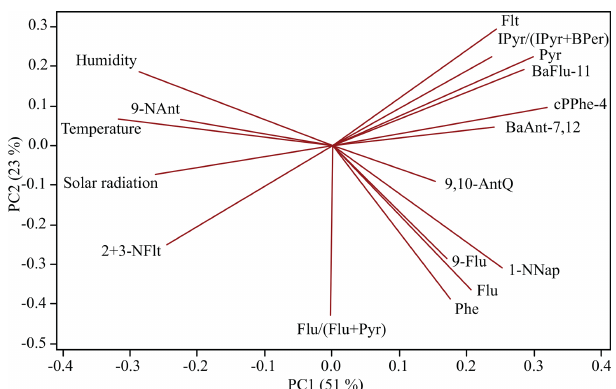
Figure 4. Principal component analysis loading plot of PC1 and PC2 for Adventdalen samples (G + P; n =